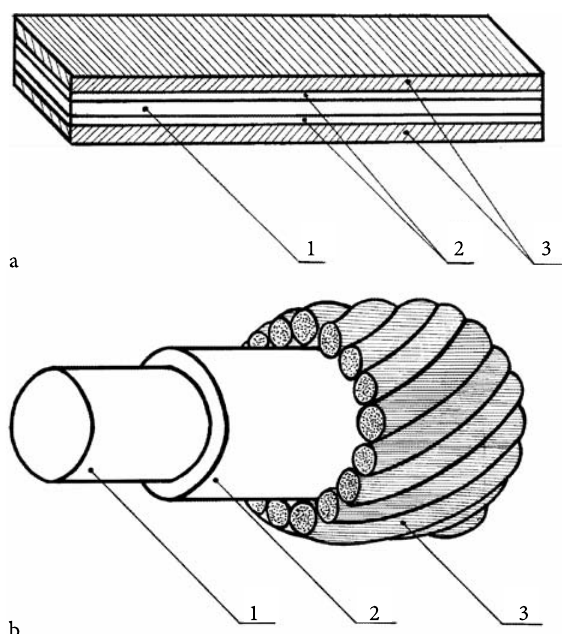
Fig. 1. Hybrid composite elements on the base of steel and